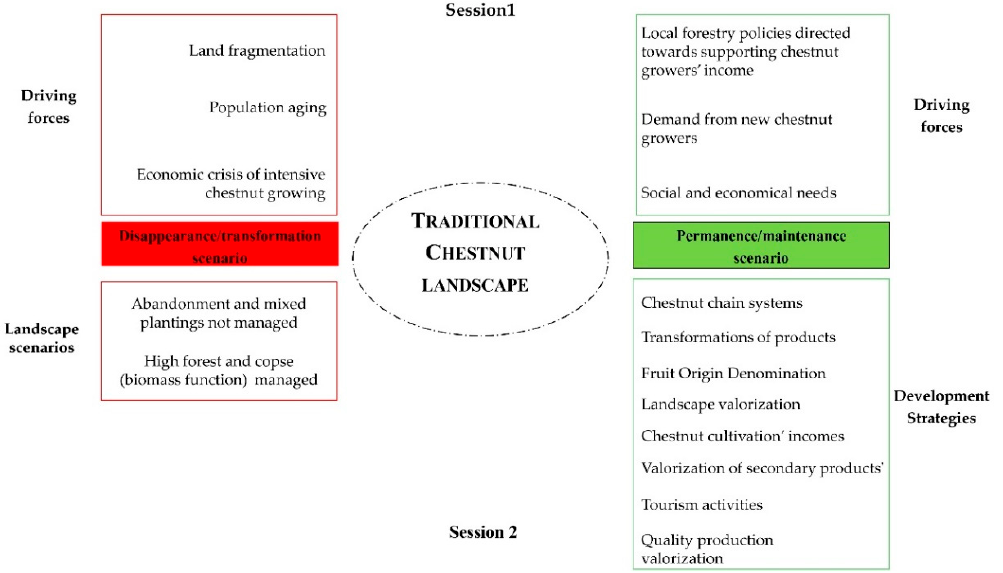
Figure 5. Scheme of the driving forces (Session 1) and the elements linked to landscape scenarios (Session 2) identified by local stakeholders during the focus group discussion that contribute to maintain and transform the traditional chestnut landscape.